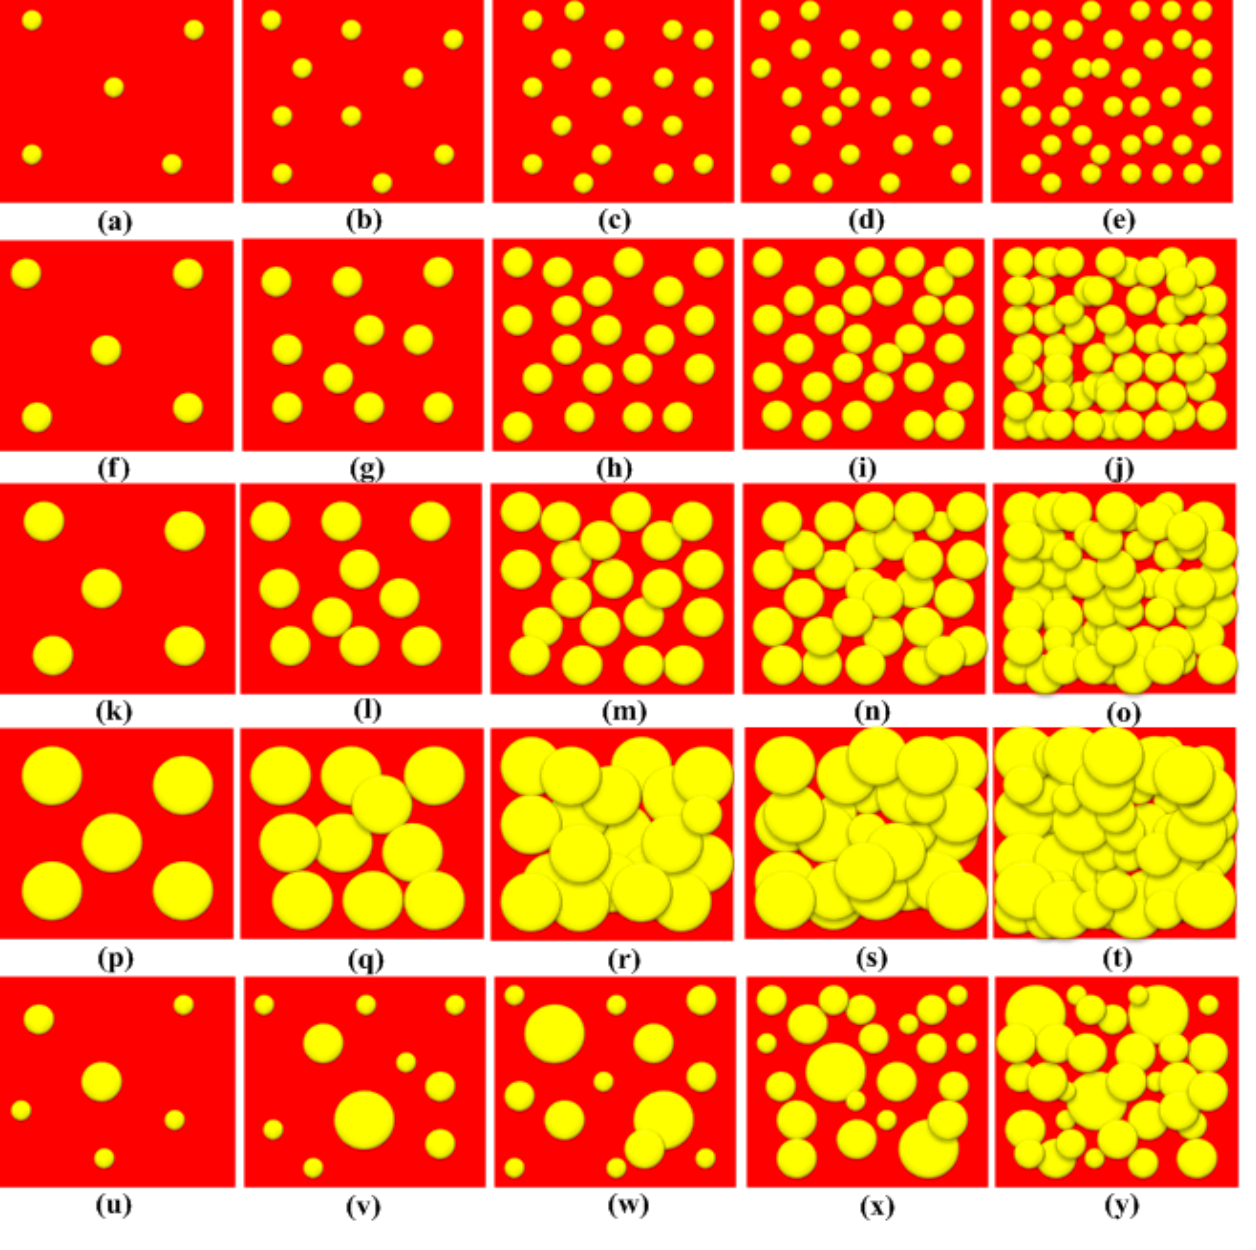
Figure 2. Schematic representation of microstructure for ( a ) AA5, ( b ) AA10, ( c ) AA15, ( d ) AA20, ( e ) AA25, ( f ) BB5, ( g ) BB10, ( h ) BB15, ( i ) BB20, ( j ) BB25, ( k ) CC5, ( l ) CC10, ( m ) CC15, ( n ) CC20, ( o ) CC25, ( p ) DD5, ( q ) DD10, ( r ) DD15, ( s ) DD20, ( t ) DD25, ( u ) OO5, ( v ) OO10, ( w ) OO15, ( x ) OO 20, and ( y ) OO25.